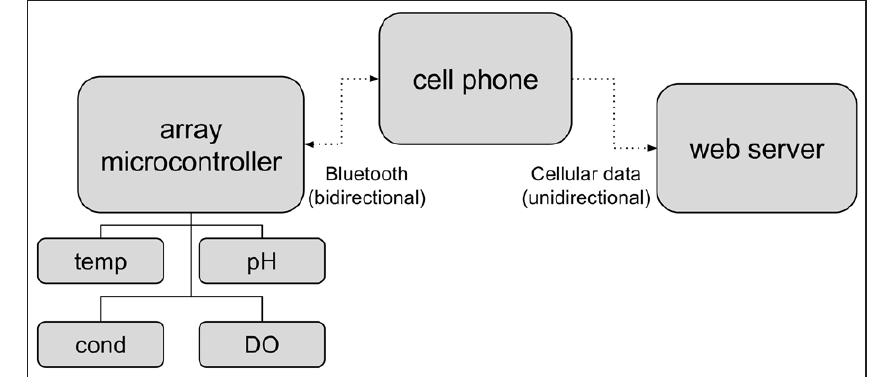
Figure 1: Water quality array system components and the communication between